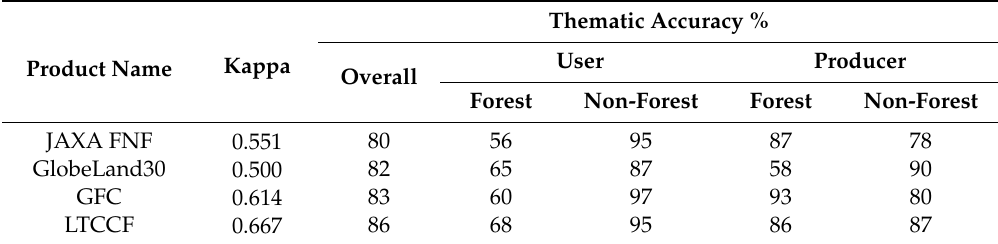
Table 3. Accuracies of satellite-derived forest masks for flatland of